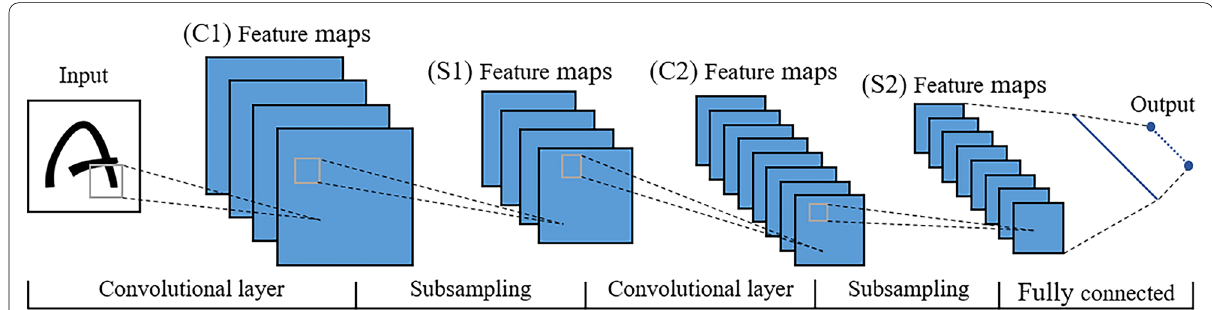
Figure 3 Deeper networks, lower error rates